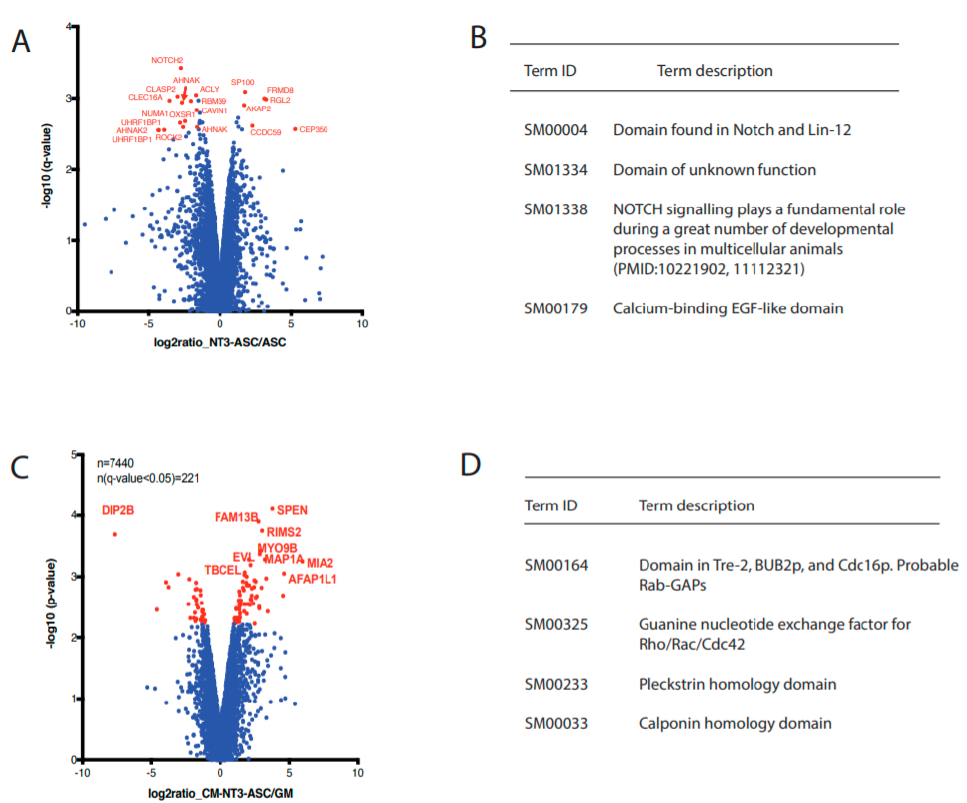
Figure 5. Quantitative phosphoproteomics analysis. ( A ) Volcano plots of phosphorylation site ratios and significance ( p -value) obtained for NT3-stimulated ASC and unstimulated ASC comparisons. Significant hits with a q -value of less than 0.05 as computed by SafeQuant using paired t-test and Benjamini-Hochberg correction are indicated in red. The proteins associated with the 21 most significantly changing phosphorylation sites are also shown, ( B ) Significantly enriched terms ( p < 0.05) found for the most significant hits using STRING, ( C ) Volcano plots of phosphorylation site ratios and significance ( p -value) obtained for CM-NT3-ASC and GM comparisons. Significant hits with a q -value of less than 0.05 as computed by SafeQuant using paired t -test and Benjamini-Hochberg correction are indicated in red. The proteins associated with the 10 most significantly changing phosphorylation sites are also shown and ( D ) Significantly enriched terms ( p < 0.05) found for the most significant hits using STRING.